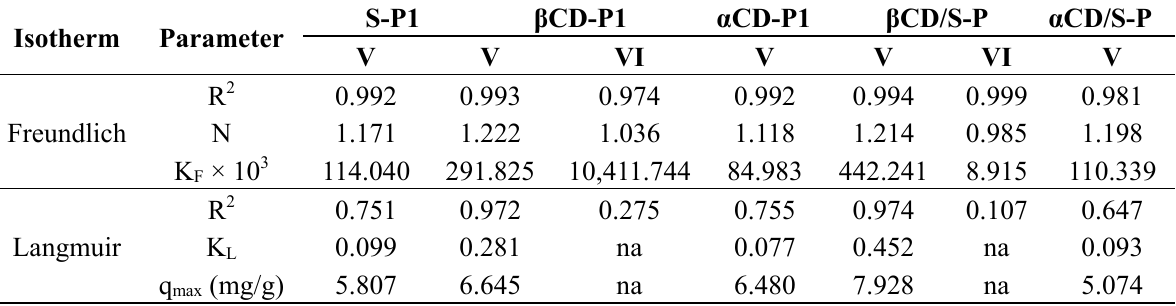
Table 5. Freundlich and Langmuir parameters for the sorption of progesterone ( V ) (5–50 ppm in methanol:water 1:9) and curcumin ( VI ) (2–16.7 mM in ethanol) on the DVS cross-linked homo- ( S-P1 and CD-P1 ) and heteropolymers ( CDS/S-P1 ) (1:1 DVS:Glc stoichiometry) (100 mg and 125 mg respectively). (Supplementary Material, Figures S10 and